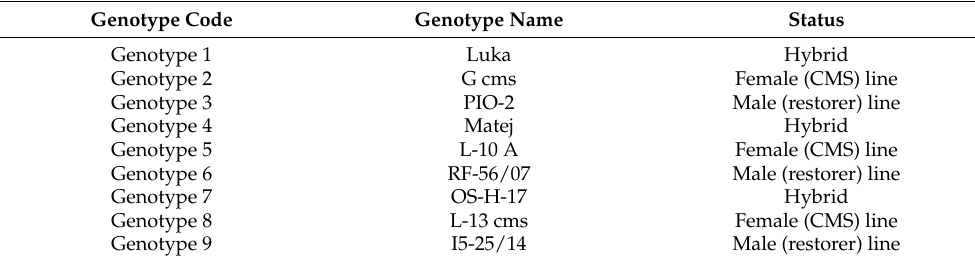
Table 1. Sunflower genotypes (AIO—Agricultural Institute Osijek) included in the